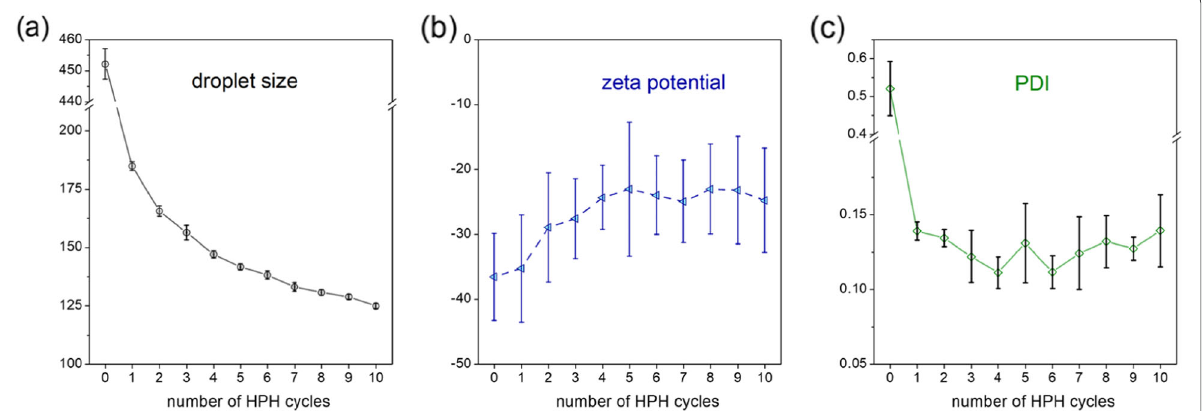
Fig.3 Variation of a d z , b ζ potentials, and c PDI as a function of the number of homogenization cycles for a cannabis-free soybean oil nanoemulsion